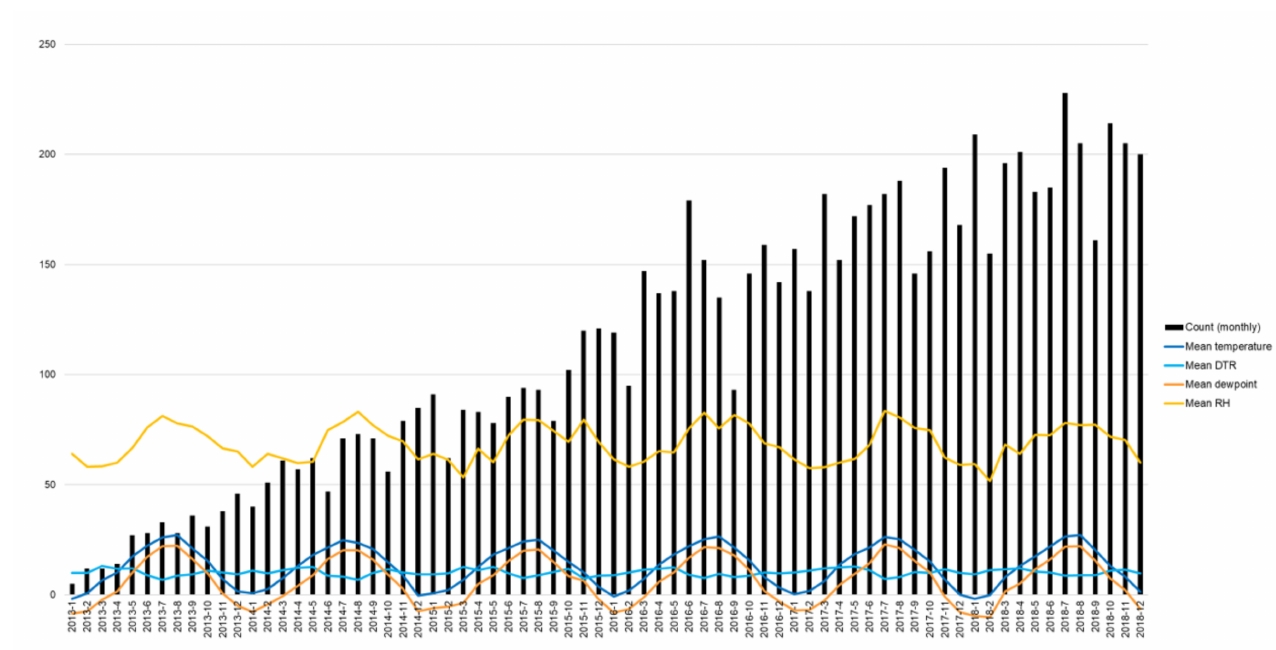
Figure 1. Diabetic foot amputation and climate trend (January 2013 − December 2018). (Note) Monthly count of diabetic foot amputation. DTR: diurnal temperature range, difference between the daily maximum and minimum temperature ranges; RH: relative humidity.